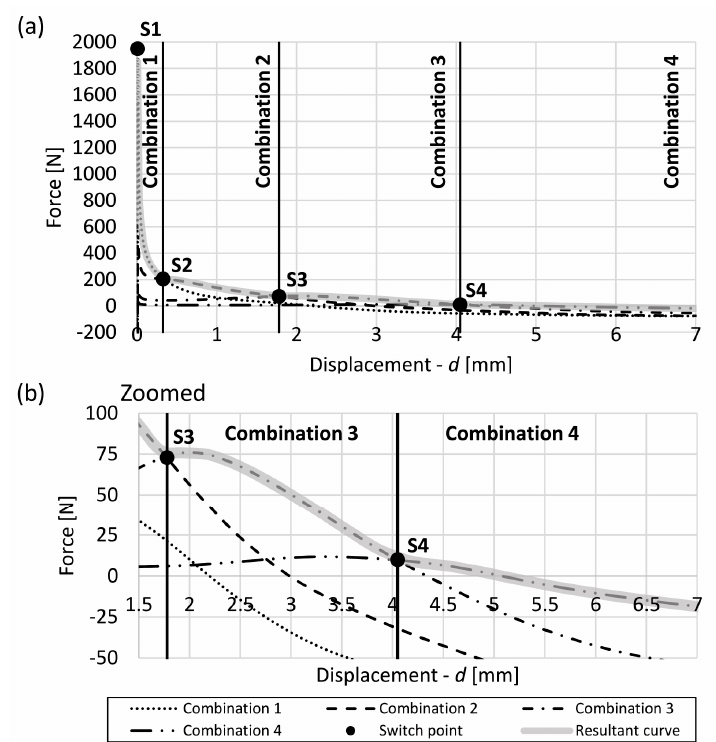
Figure 6. The resulting multi-static force-displacement F ( d ) characteristic obtained with different combinations of coil activations ( a ) F ( d ) during the entire actuation cycle and ( b ) zoomed F ( d ) for the displacements obtained with simultaneous activation of coils 4 and 5 and with activation of the coil 5 only.